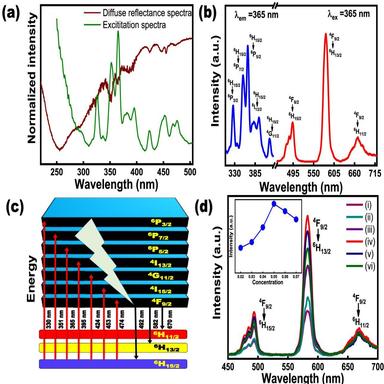
(a) Photoluminescence excitation spectra along with the reflectance spectrum, (b) photoluminescence emission and excitation spectra of Li2MgZr0.95Dy0.05O4 phosphors. (c) Schematic energy level diagram of Dy3+ in Li2MgZr1xDyxO4 phosphors. (d) Modification in PL emission spectra of Li2MgZr1xDyxO4 phosphors with the increase in Dy3+ concentration. The inset shows the corresponding variation of integral emission intensity.